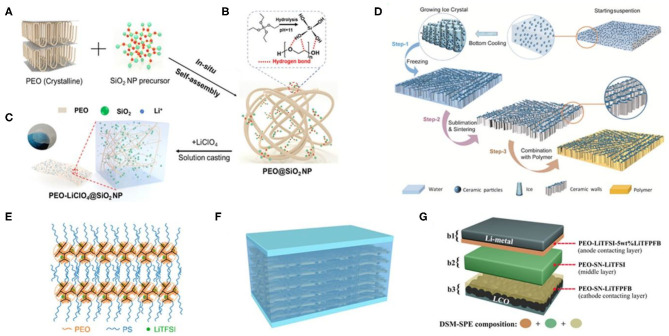
(A–C) Synthetic routes of the SiO2-PEO–LiClO4 solid-state polymer electrolytes (SPEs). (D) The schematic preparation process of the ice-templated Li1.5Al0.5Ge1.5(PO4)3 (LAGP)-PEO SPEs. Reproduced with permission from Wang X. et al. (2019) and Xu et al. (2020). (E) Schematic structure of the lamellar PS–PEO–LiTFSI SPEs. Reproduced with permission from Chen et al. (2019). (F) Schematic of the PEO|PEO–perovskite|PEO composite solid electrolyte. (G) Schematic of the multilayered solid polymer electrolyte (DSM-SPE). The bilateral layers are in situ formed on the surfaces of electrodes. Reproduced with permission from Wang C. et al. (2019) and Liu K. et al. (2019).